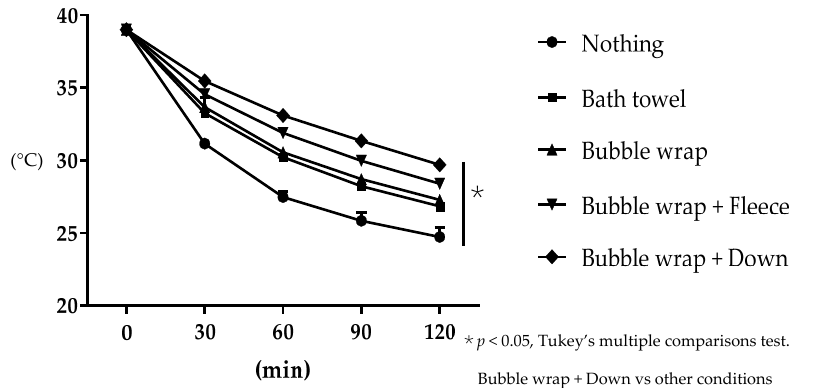
Figure 3. Temperature changes over time for the five heat insulators (filled circle, nothing; filled square, bath towel; triangle, bubble wrap; reversed triangle, bubble wrap and fleece; diamond, bubble wrap and down). Significant differences were observed between each condition at all measurement points ( p < 0.05, Tukey’s multiple comparison test). The combination of bubble wrap and down is most effective in preventing temperature loss. min: minutes. Table 1. Profiles of 24 dogs used in examination in this